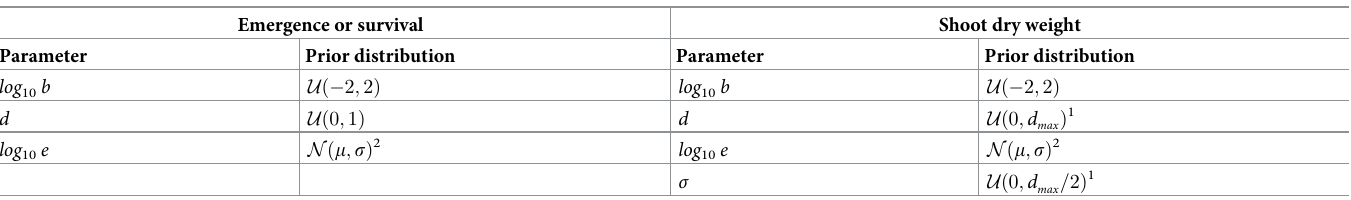
Table 2. Specification of prior distributions for model parameters.